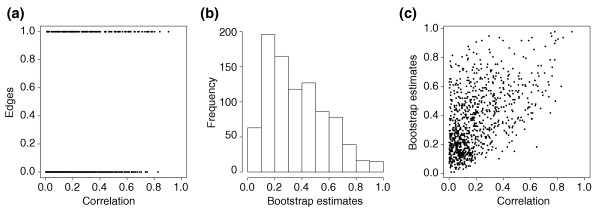
Bootstrapped GGM of the isoprenoid pathway. (a) Comparison between absolute pairwise correlation coefficients and presence of edges. Dots at 0 and 1 denote absent and present edges respectively. (b) Histogram of the bootstrap edge probabilities. (c) Comparison between absolute pairwise correlation coefficients and bootstrap edge probabilities for all 780 possible edges.